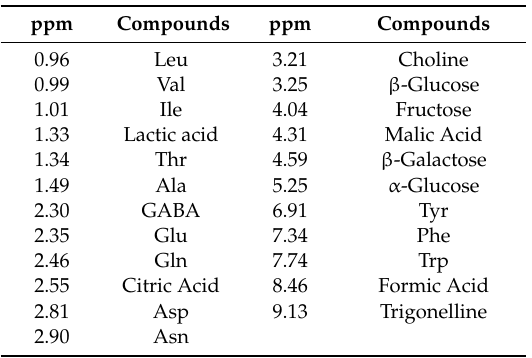
Table1. Compoundsandrelativesignals(ppm)selectedforquantitativeanalysisinthehydroalcoholicextracts. ppm Compounds